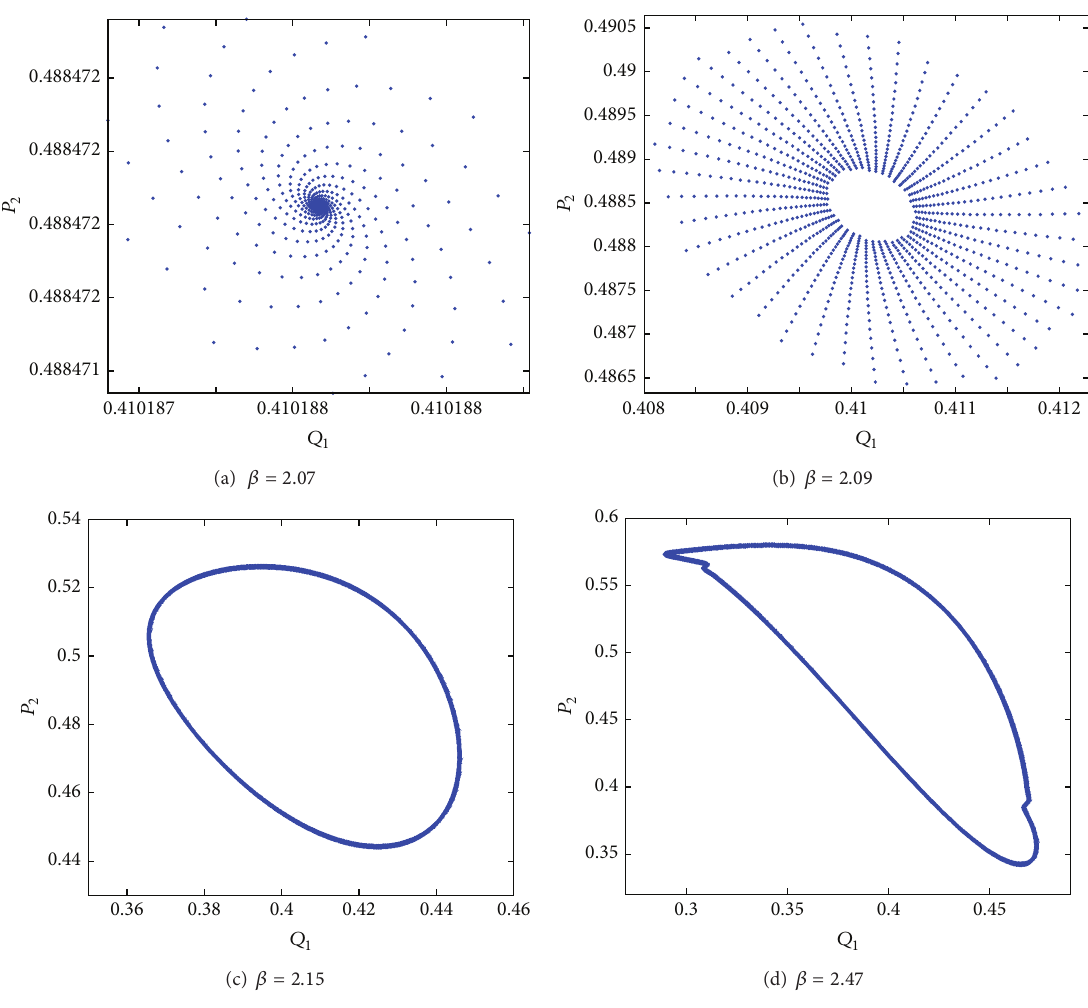
Figure 8: The phase space diagrams of system (10) for 𝛼 = 2.5